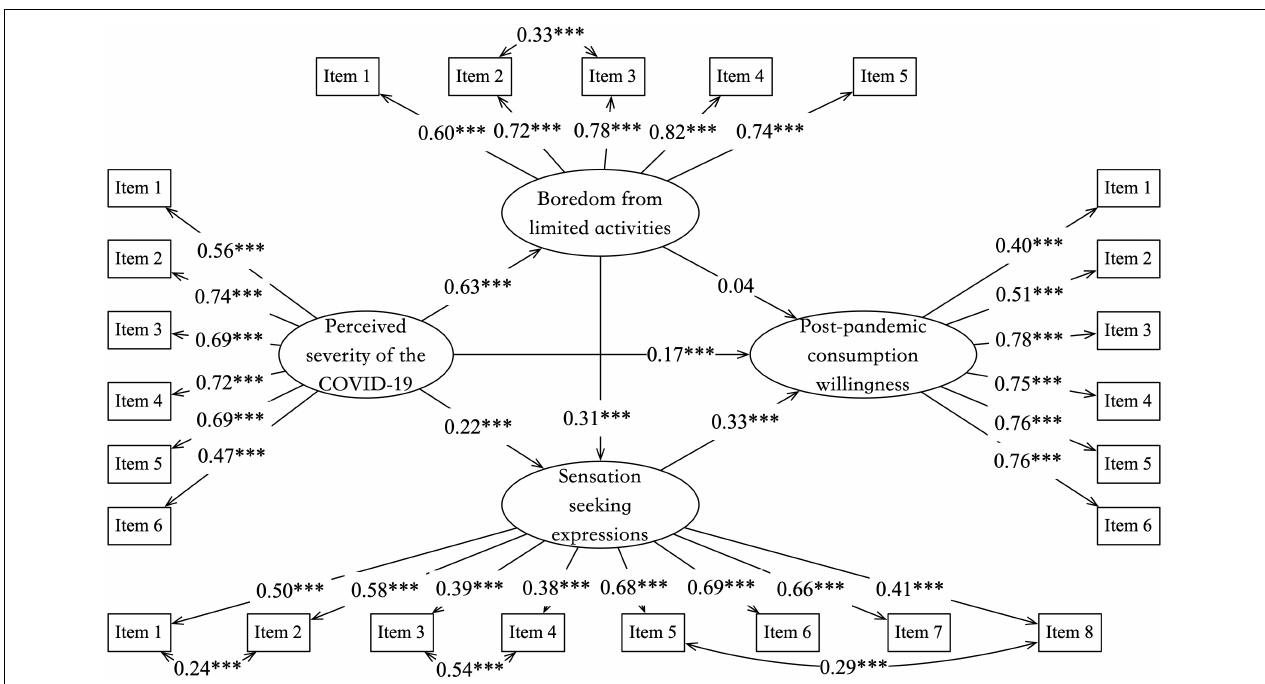
FIGURE 1 | Perceived severity of COVID-19 results in an increased post-pandemic consumption willingness through the mediating roles of boredom from limited activities and sensation-seeking expressions (Study 1). Numbers are the standardized path coefficient, *** p <